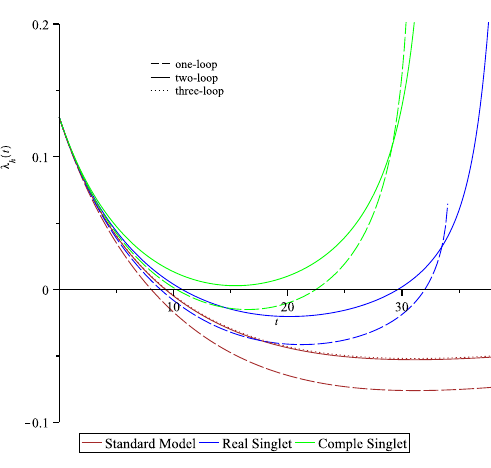
Figure 6 . Comparison between the behavior of Higgs self-coupling in different